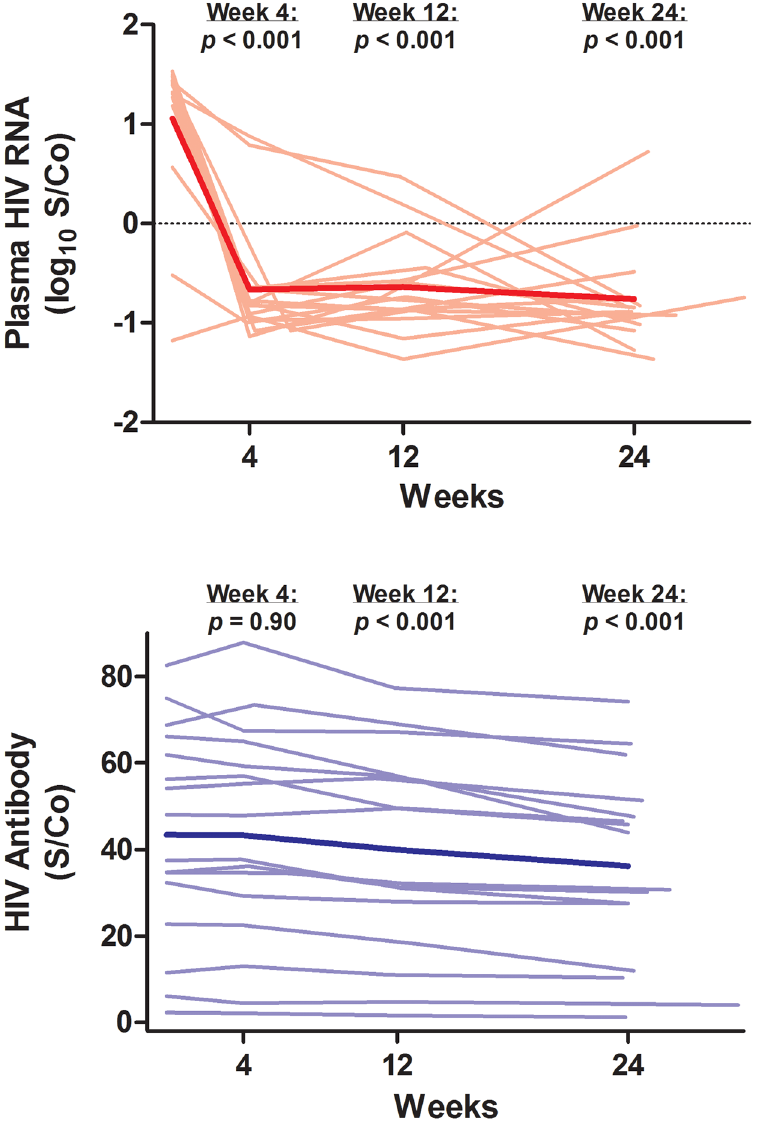
Figure 2. Change in ultrasensitive plasma HIV RNA and HIV antibody levels. Thin lines indicate data for each individual subject. The thick line indicates the estimated mean value over time from mixed effects linear regression. P-values refer to change from baseline at each referenced time-point. S/Co=signal/cutoff ratio.